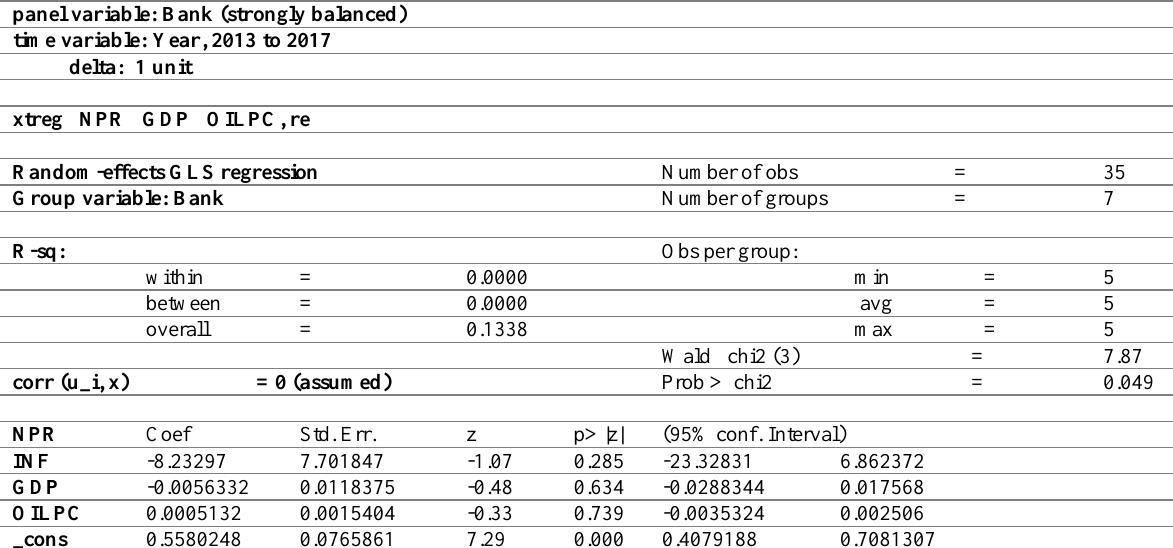
Table 4: Analysis on the Impact of Macroeconomic Factors on NPR